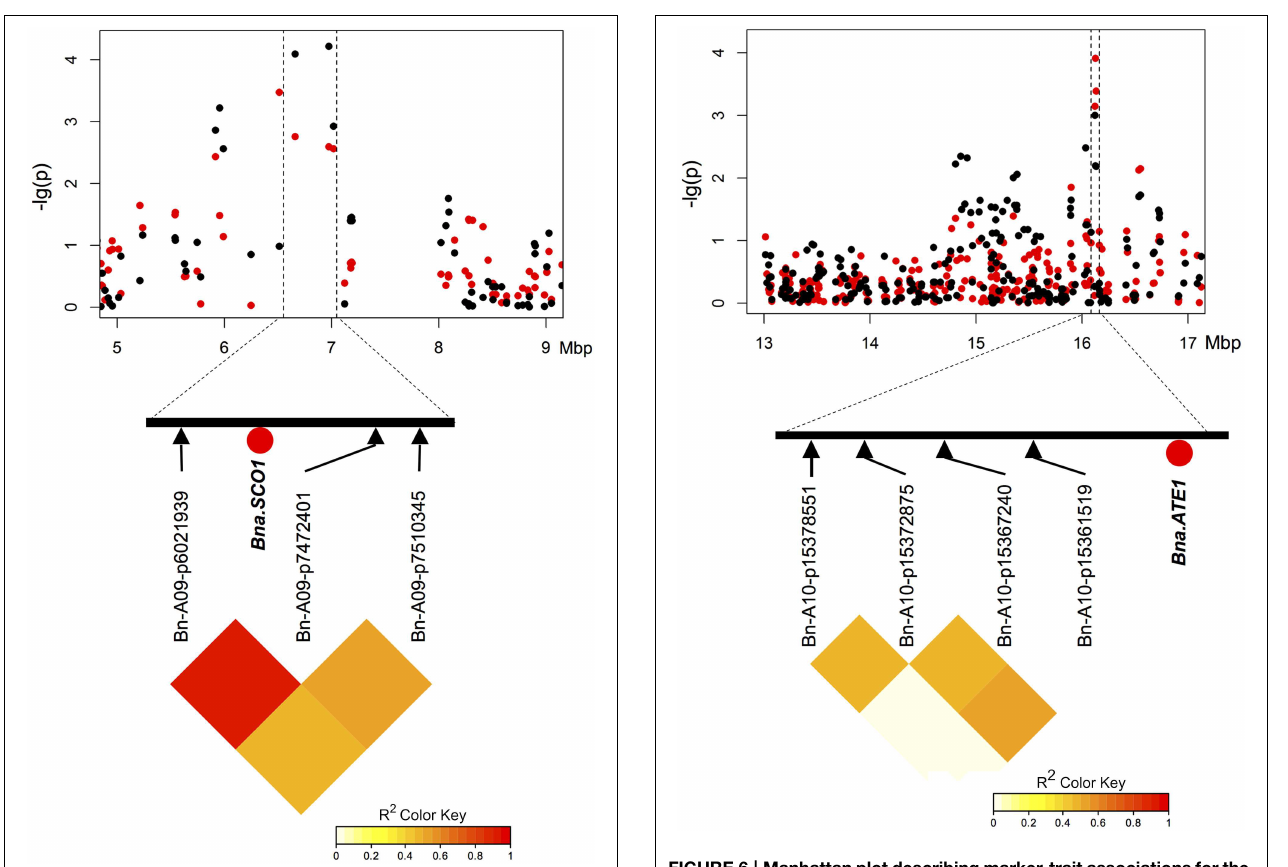
FIGURE 6 | Manhattan plot describing marker-trait associations for the trait ES for the chromosomal region around candidate BnaA10g24850D (Bna.ATE1) on chromosome A10, and correlations between markers of the linkage group harboring BnaA10g24850D . Red dots represent associations calculated for SL2011. Black dots represent associations for